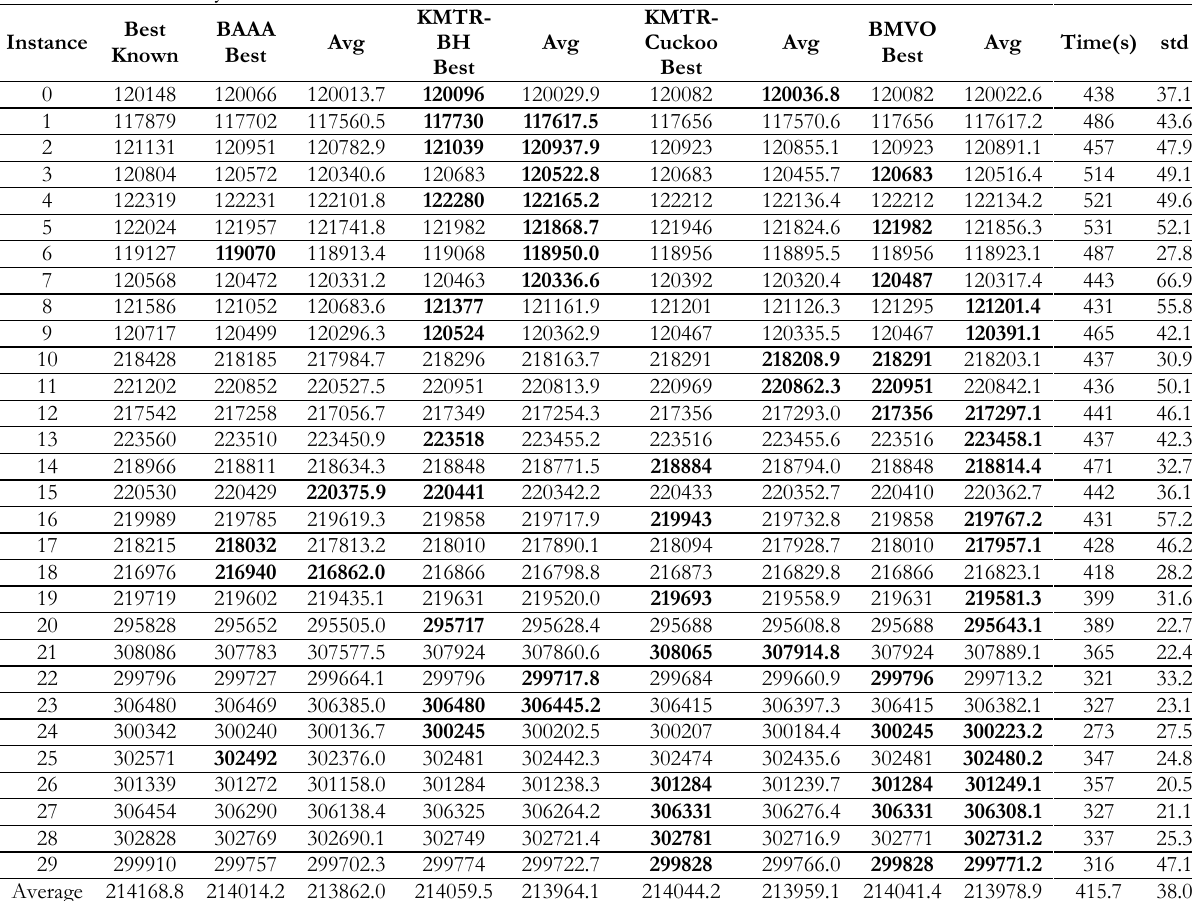
Table 3. OR-Library benchmarks MKP CB.5.500